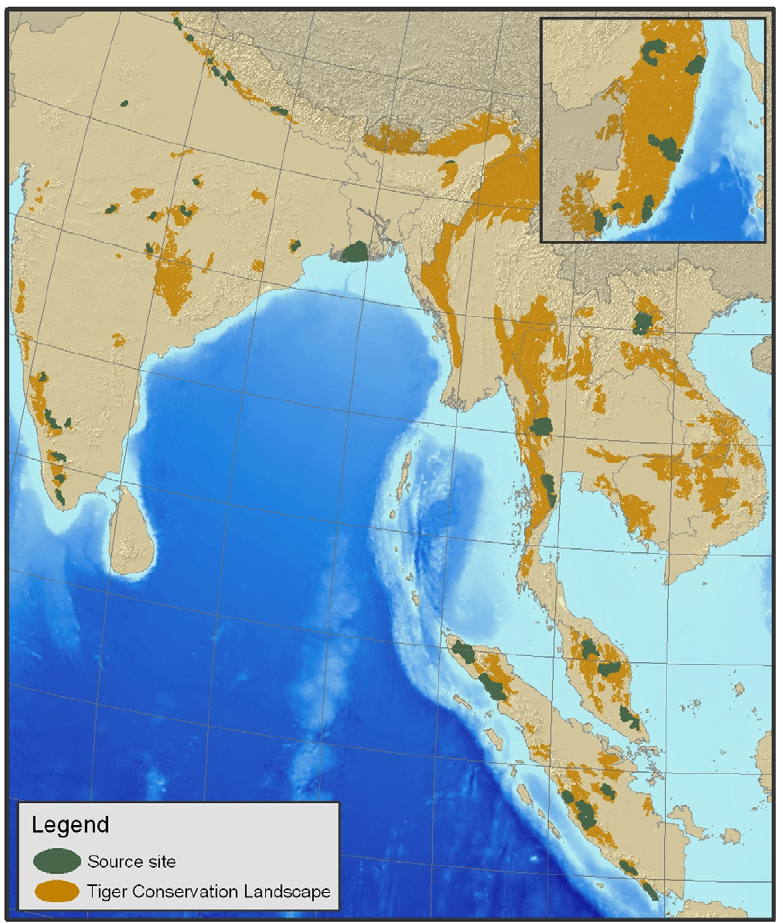
Figure 1. Location of 42 source sites, embedded within the larger tiger conservation landscapes (TCLs), areas that encompass the ecological habitats suitable for tigers.